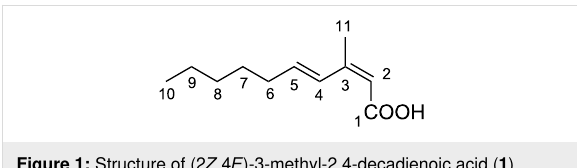
Figure 1: Structure of (2 Z ,4 E )-3-methyl-2,4-decadienoic acid ( 1 ).